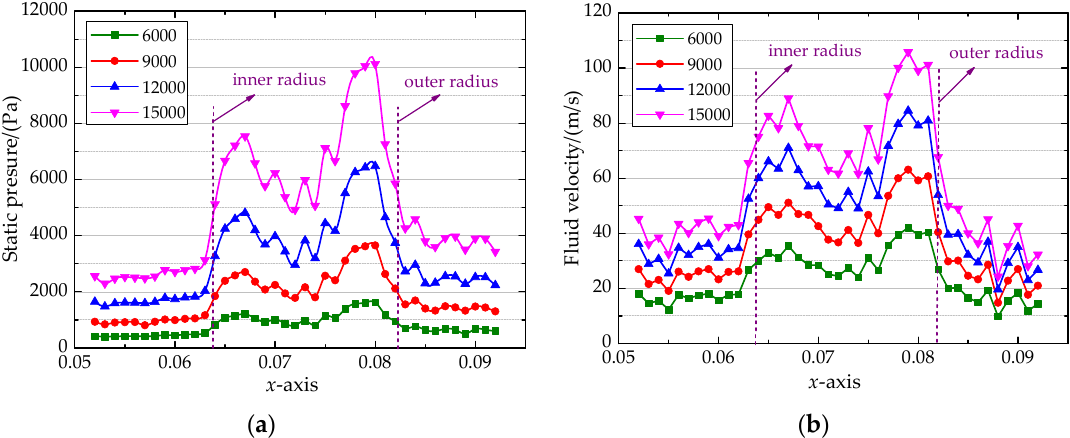
Figure 9. The distribution without shroud at different rotational speeds of: ( a ) static pressure; ( b ) fluid velocity.